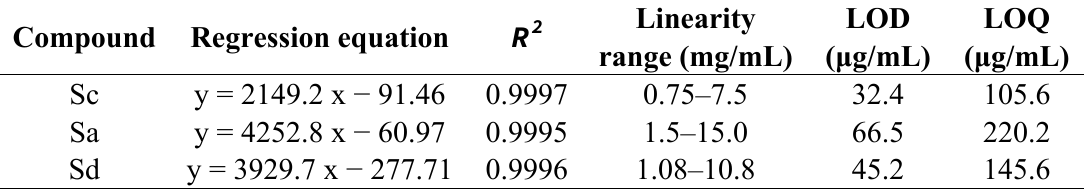
Table 1. Linear regression equation, correlation coefficient and linearity of three saikosaponins in B. falcatum